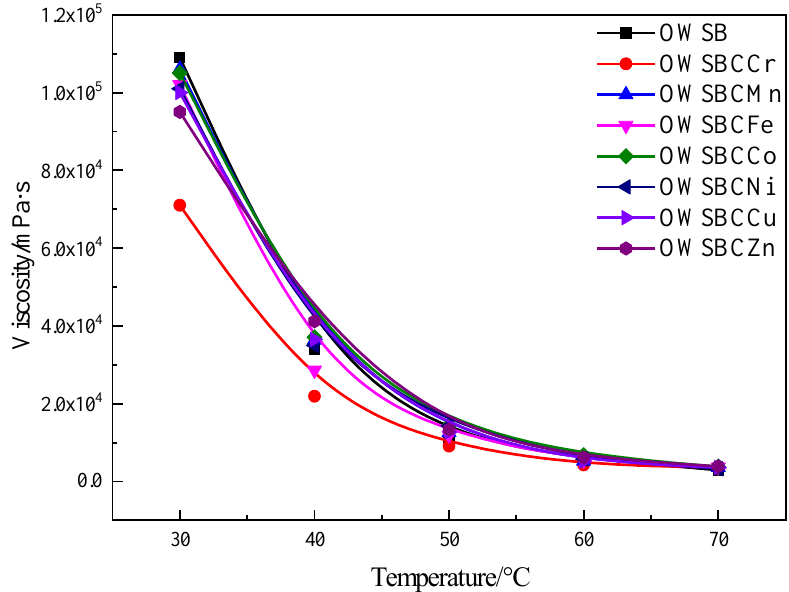
Figure 7. The effect of different metal-loaded sodium bentonite samples on viscosity reduction.